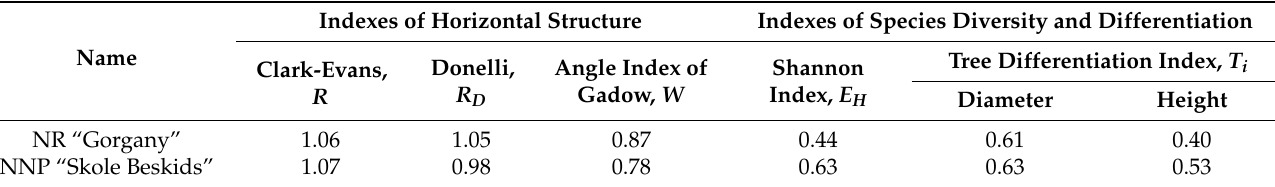
Table 4. The main criteria of the stands